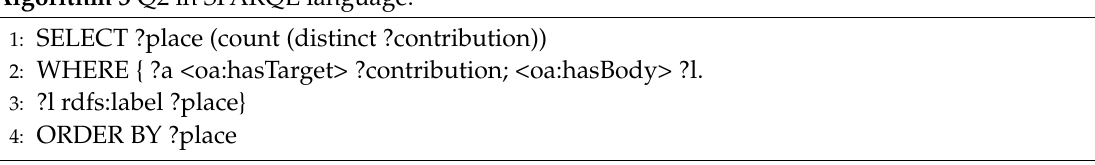
Algorithm 3 Q2 in SPARQL